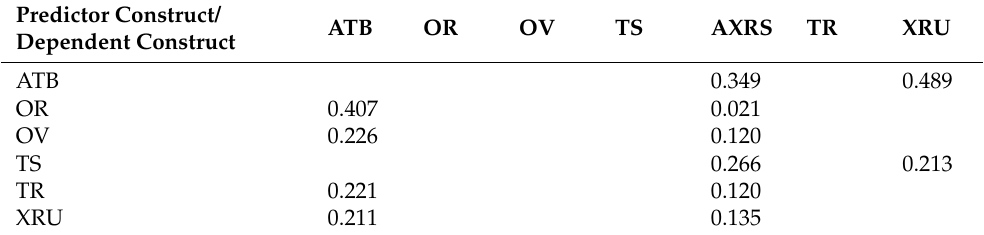
Table 9. Effect size (f 2